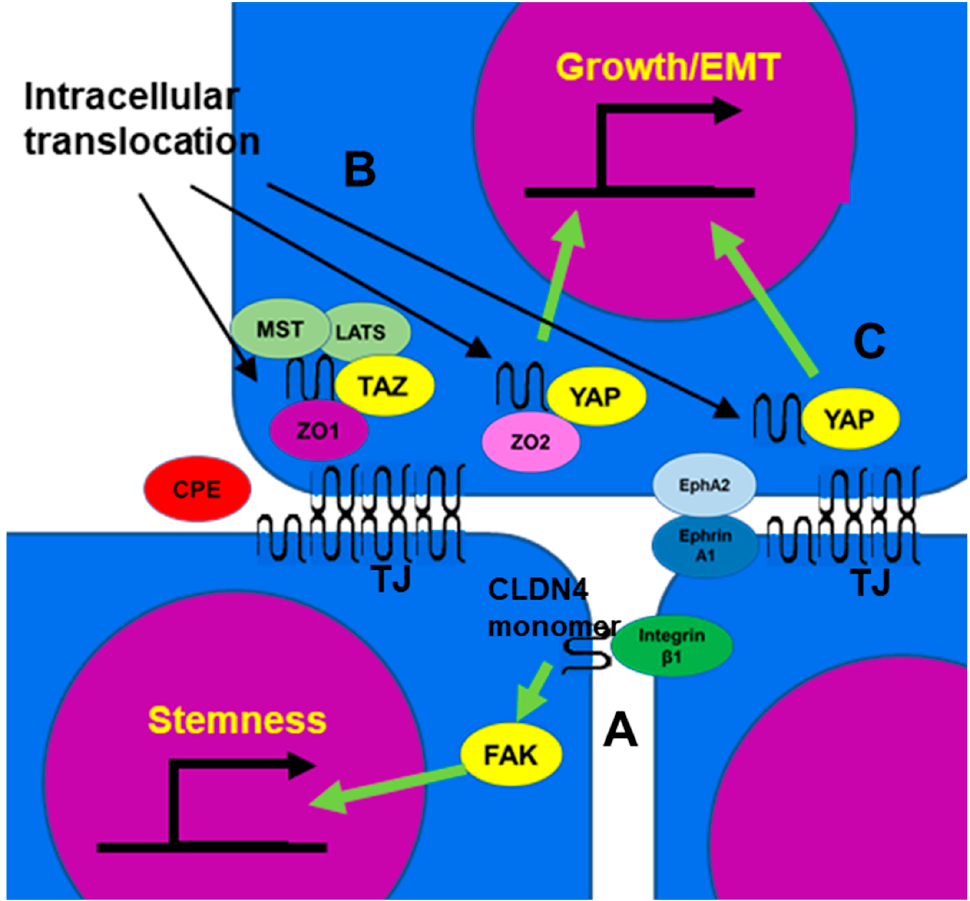
Figure 2. The function of non-TJ CLDN4. (A) CLDN4 monomer that does not form TJs is a binding partner for integrin β 1 expressed in neighboring tumor cells, activates FAK, and promotes expression of stemness-associated genes. (B) CLDN4 translocates into the cytoplasm from TJs disrupted by CPE and forms a stable complex with TAZ, MST, LATS, and ZO1, but YAP is released from the complex and translocates into the nucleus with ZO2 to induce expression of YAP target genes, leading to proliferation and EMT. (C) EphA2 activated by Ephrin A1 expressed on the surface of neighboring cells phosphorylates CLDN4 and releases it from TJs. The released CLDN4 is translocated into the nucleus with YAP. CLDN4, claudin-4; TJ, tight junction; CPE, Clostridium perfringens enterotoxin; TAZ, tafazzin; YAP, yes-associated protein; ZO, zonula occludens; MST, mammalian Ste20-like kinase; LATS, large tumor suppressor kinase; Eph A2, ephrin type-A receptor 2; FAK, focal adhesion kinase; EMT, epithelial-mesenchymal transition.